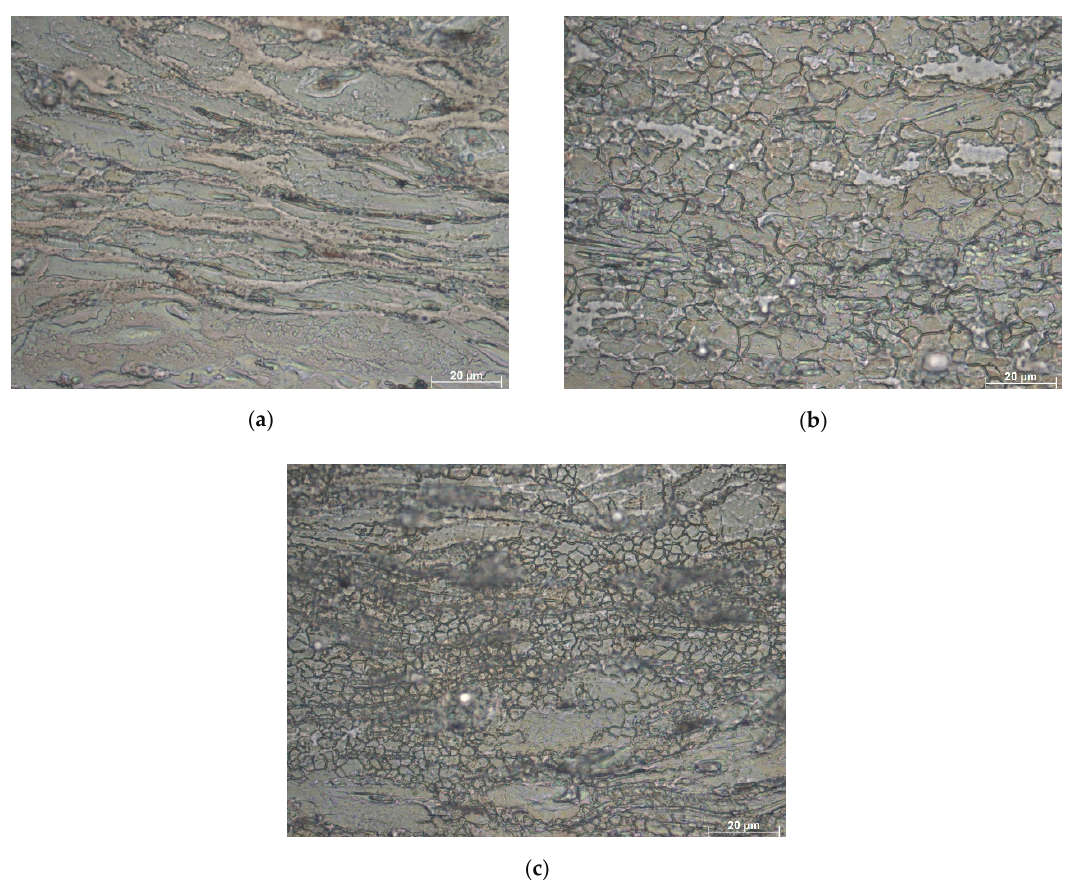
Figure 10. The microstructures of the Mg–4.5 Li–1.5 Al + 0.2 TiB at different deformation strain rates and temperatures: ( a ) 250 °C/0.01 s − 1 , ( b ) 350 °C/0.01 s − 1 , and ( c ) 350 °C/1 s − 1 .